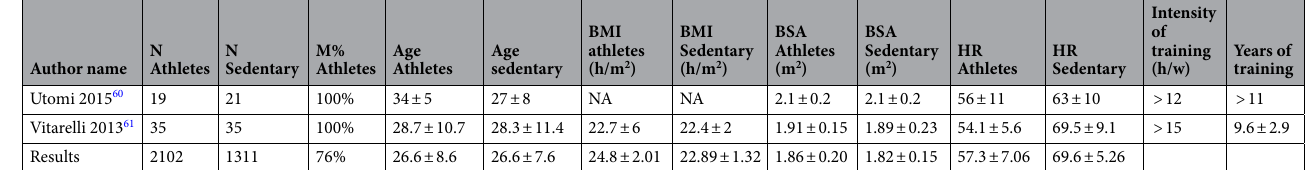
Table 1. Population demographics in ECHO studies. ♀ Data on female extracted from article with mixed population (including both sex). °Data on athletes aged < 18 extracted from article with age mixed population. ◄ Different athletes population analysed in the same article with the same sedentary control. NA, not available; M%, percentage ofmale. h/w =